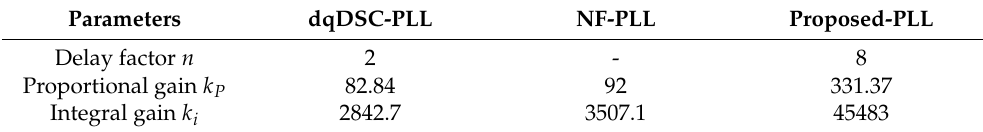
Table 1. The controller parameters.